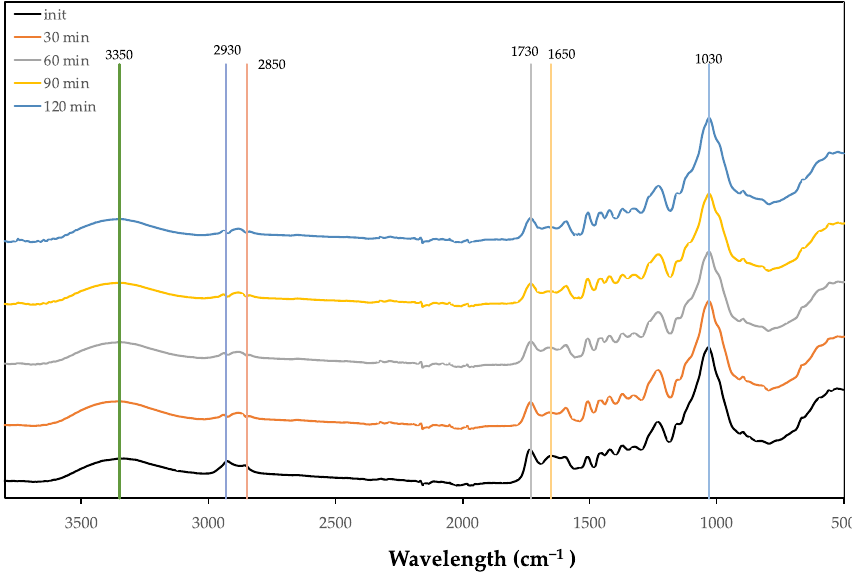
Figure 6. FTIR spectra of the original and liquified material from hydrolysed SCS at 170